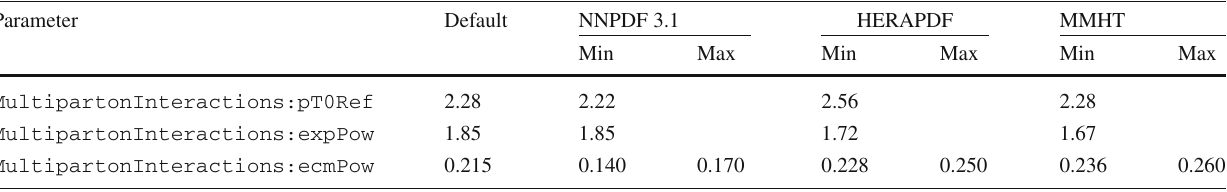
Table 1 Table showing the values of changed parameters relative to the default Monash2013 tune of Pythia 8.2 in variants where the PDF has been changed